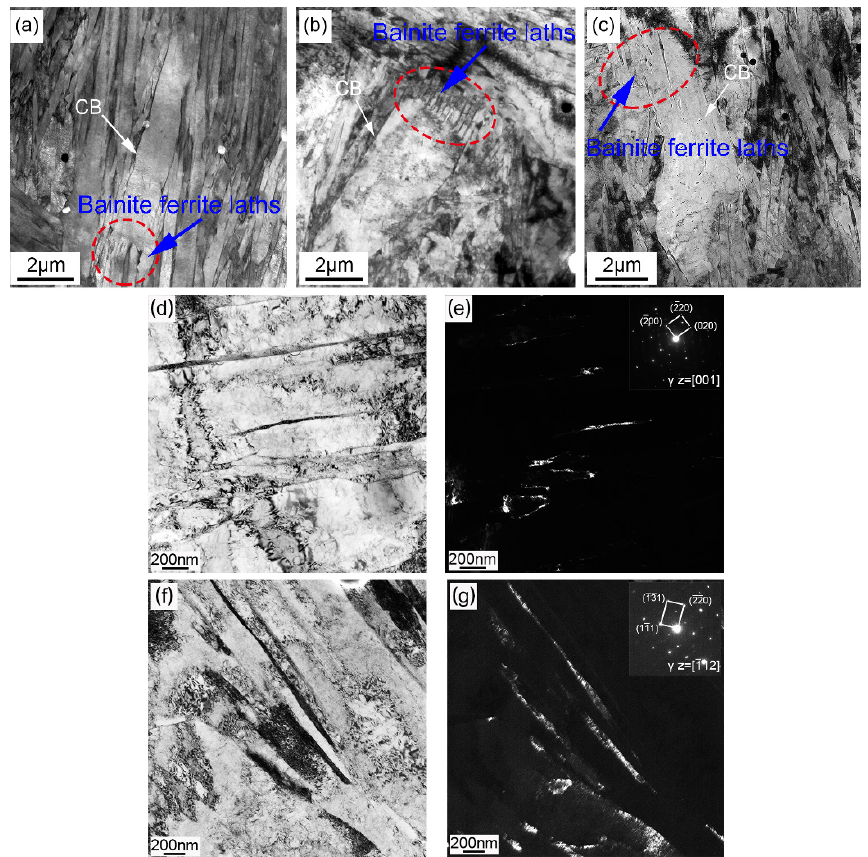
Figure 11. TEM images of the deposited metals; ( a – c ) CB in the deposited metals of Ni5.5, Ni6.5, and Ni7.5, respectively; ( d , f ) are bright field images of Ni6.5 and Ni7.5, respectively; ( e , g ) are dark field images of Ni6.5 and Ni7.5, respectively.